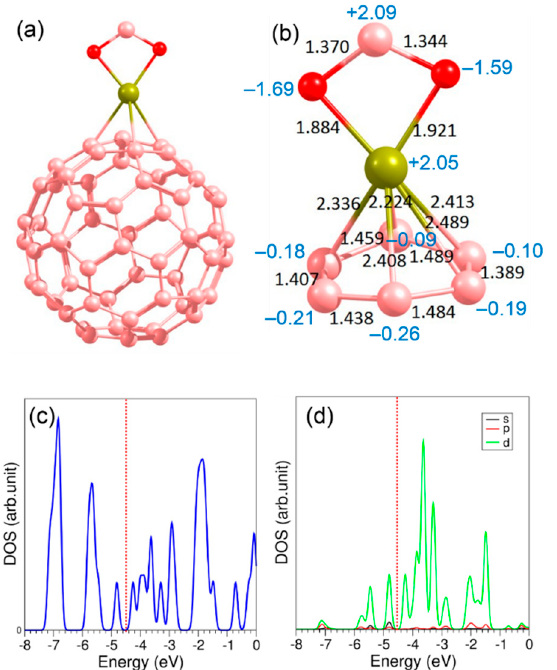
Figure 6. Relaxed structure of ( a ) a CO 2 molecule adsorbed on the Ti-supported surface, ( b ) bond distances and Bader charges on the atoms, ( c ) total DOS plot and ( d ) atomic DOS plot of Ti. Adsorption energy of the CO 2 molecule was calculated. Adsorption is exoergic with an adsorption energy of − 1.57 eV. Adsorption becomes less negative (by 0.06 eV) without dispersion. Adsorption is exoergic as confirmed by the strong bonding between Ti and oxygen in the CO 2 molecule. The resultant configuration exhibits a narrow-gap semicon- ductor (see Figure 6c). The states appearing around the Fermi level are contributed to by the d states of Ti (see Figure 6d).